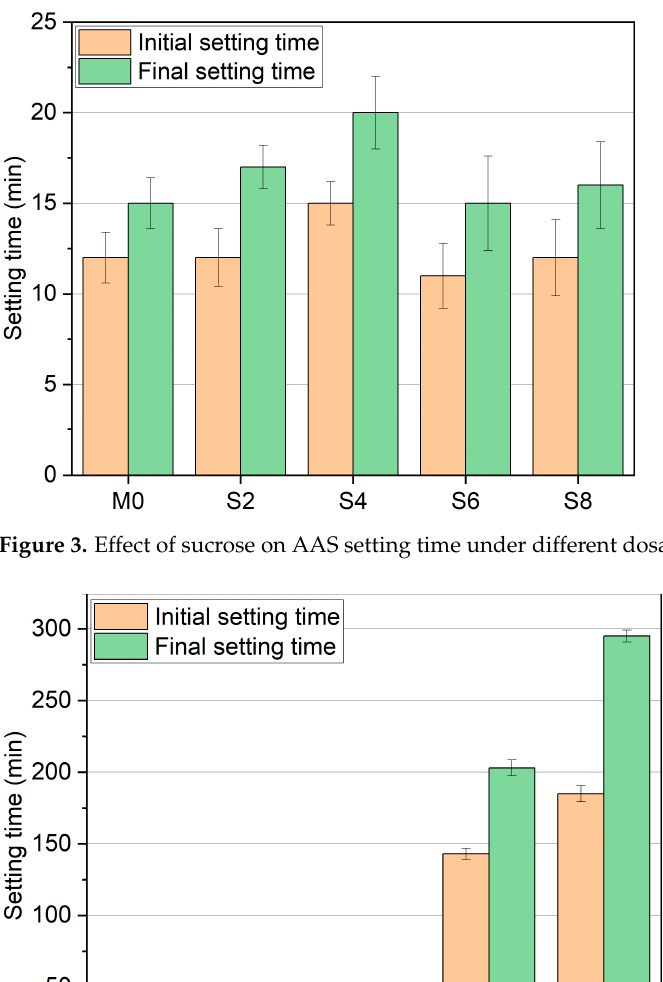
Figure 3. E ff ect of sucrose on AAS se tt ing time under di ff erent dosages.